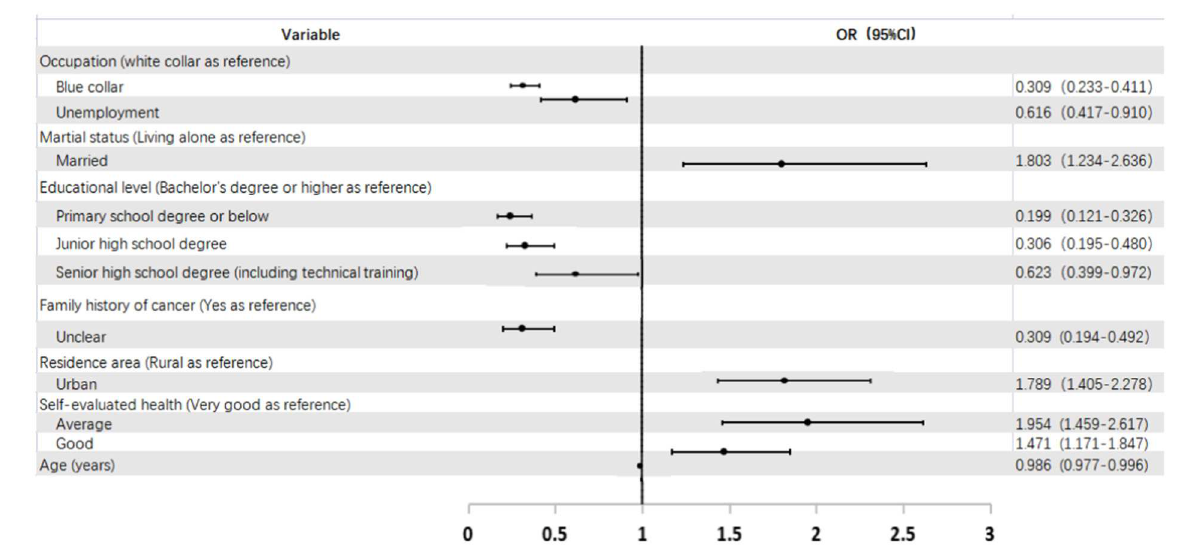
area of residence, occupation, educational level, marital status, family history of cancer, and self-evaluated health